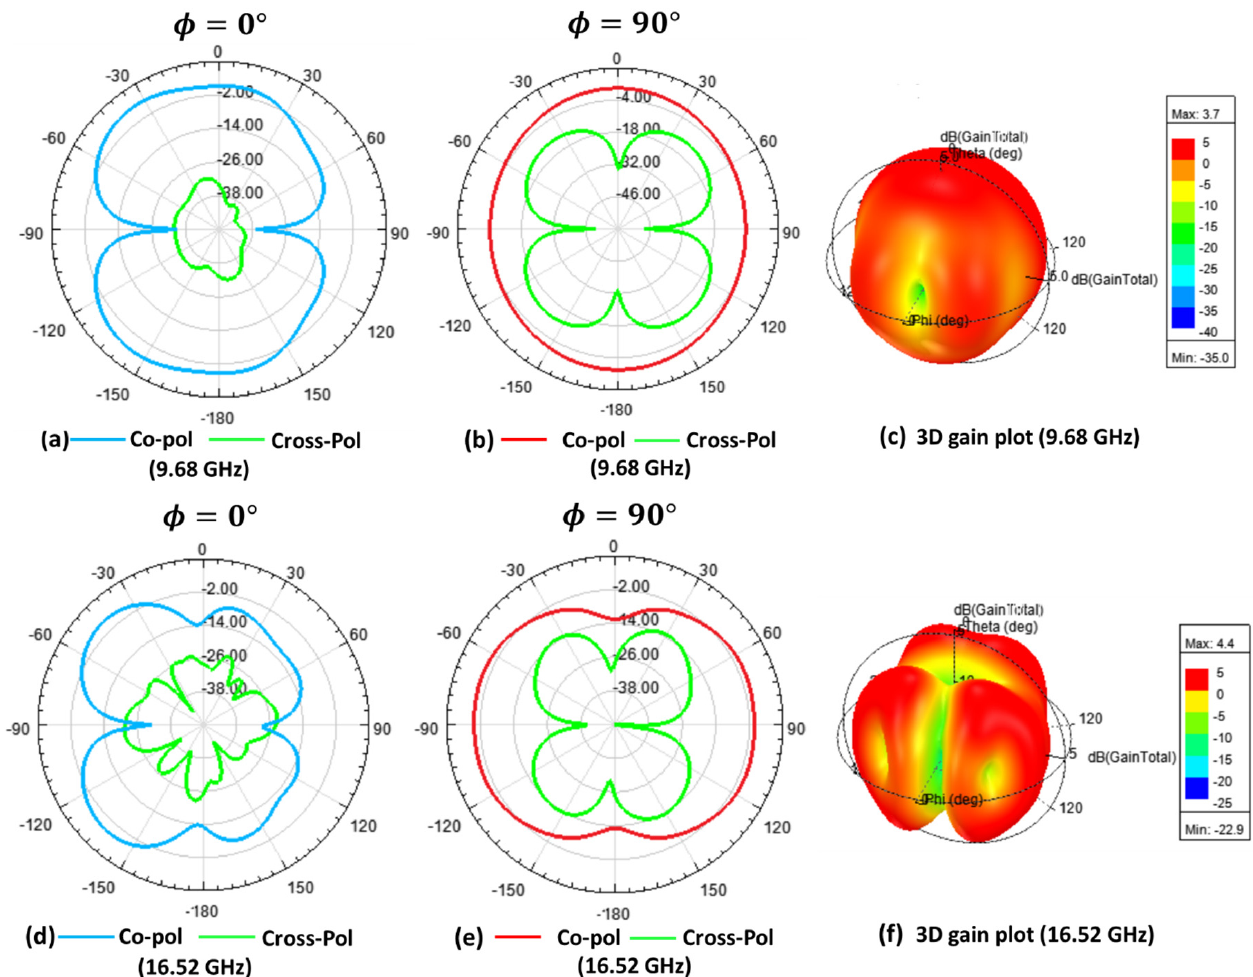
Figure 11. The simulated co- and cross-polarization and 3D gain plot: ( a ) The x-z plane; ( b ) The y-z plane; ( c ) The 3D gain plot at 9.68 GHz; ( d ) The x-z plane; ( e ) The y-z plane; and ( f ) The 3D gain plot at 16.52 GHz.